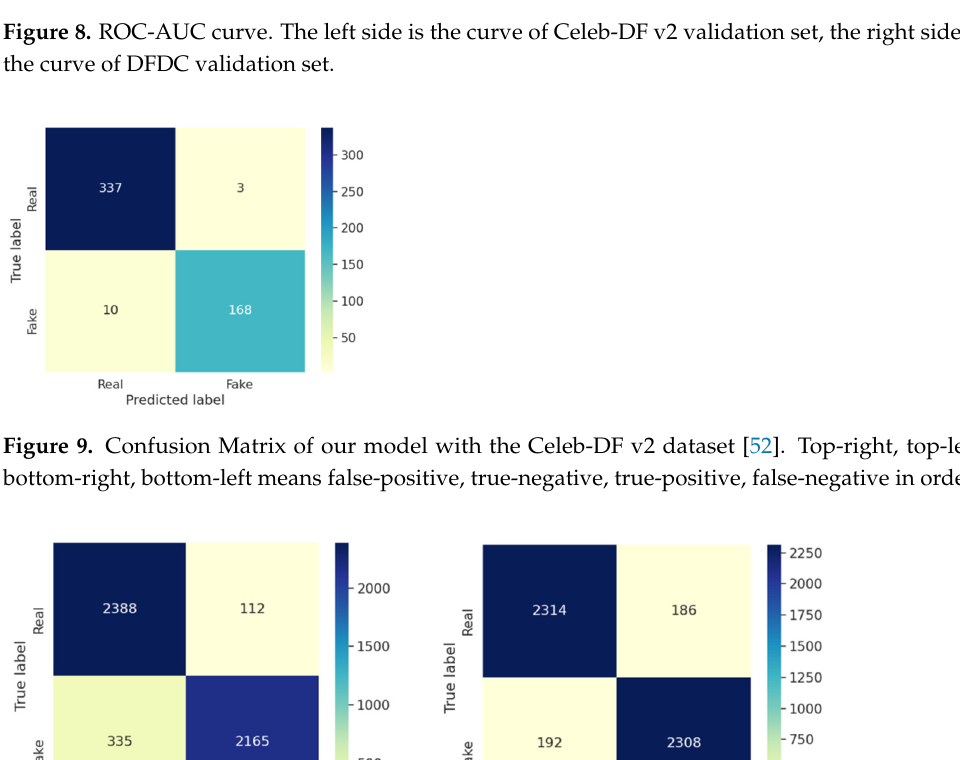
Figure 9. Confusion Matrix of our model with the Celeb-DF v2 dataset [52]. Top-right, top-left, bottom-right, bottom-left means false-positive, true-negative, true-positive, false-negative in order.